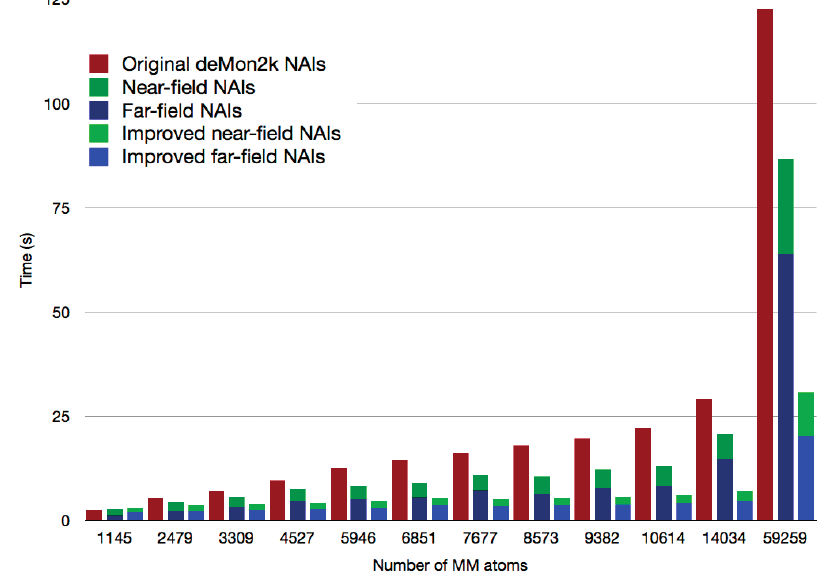
Figure 1. NAI calculation time for selected QM/MM systems using the original deMon2k code (red bars), the asymptotic expansion (dark blue and dark green bars) and the asymptotic expansion with the improved distance calculation algorithm (light blue and light green bars). Times refer to parallel runs with 12